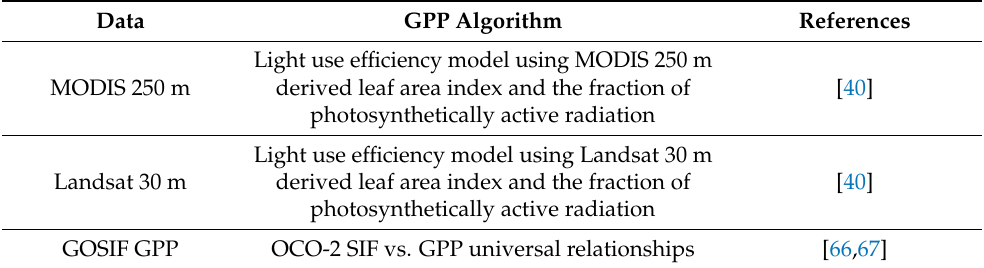
Table 4. Summary of the GPP algorithm for the remote sensing data set used in this